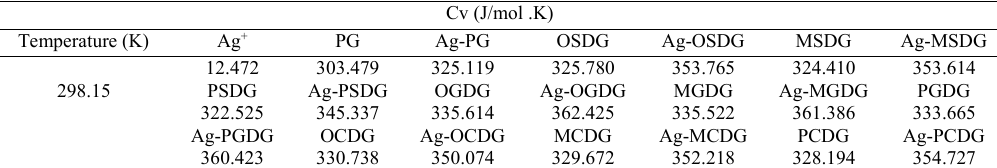
Table 5. The specific heat capacity of the investigated materials in this study Cv (J/mol .K)